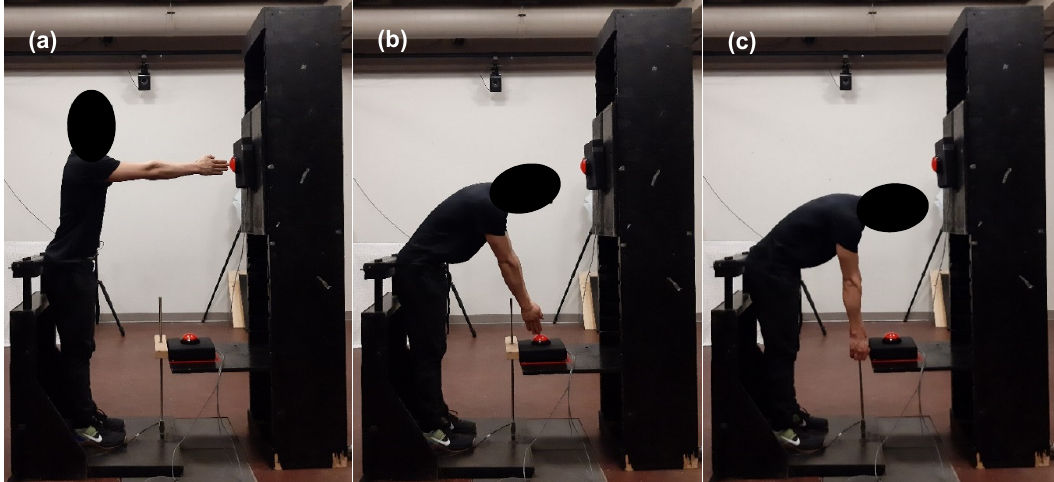
Figure 1. Participants were constrained at the hip for the spine flexion-extension task. To begin, ( a ) participants touched the first target placed at shoulder-level, then ( b ) flexed their spine to touch the second target placed at knee-level, before ( a ) returning to the initial position. For the maximal lift strength assessment, ( c ) participants exerted maximal effort to pull upwards on the load cell handle that was set at knee-level.